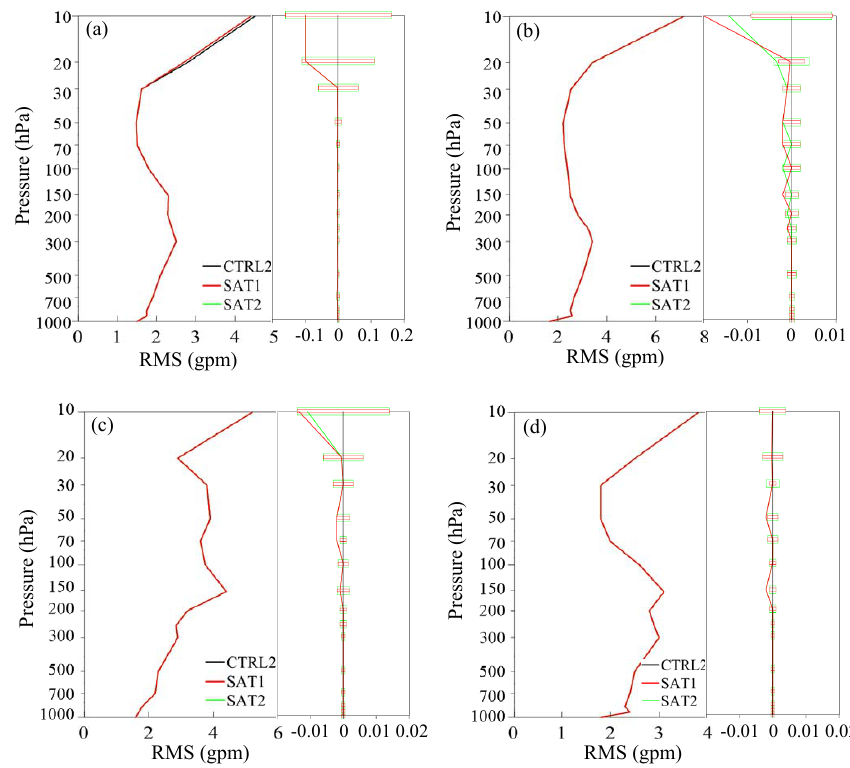
Figure 16. Same to Fig.15 but for RMS of U